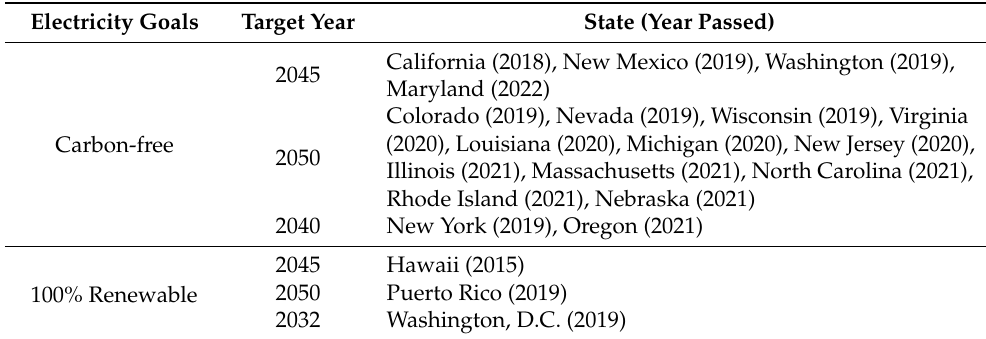
Table 1. States that have set zero-carbon/100% renewable energy (grid) goals [8]. Electricity Goals